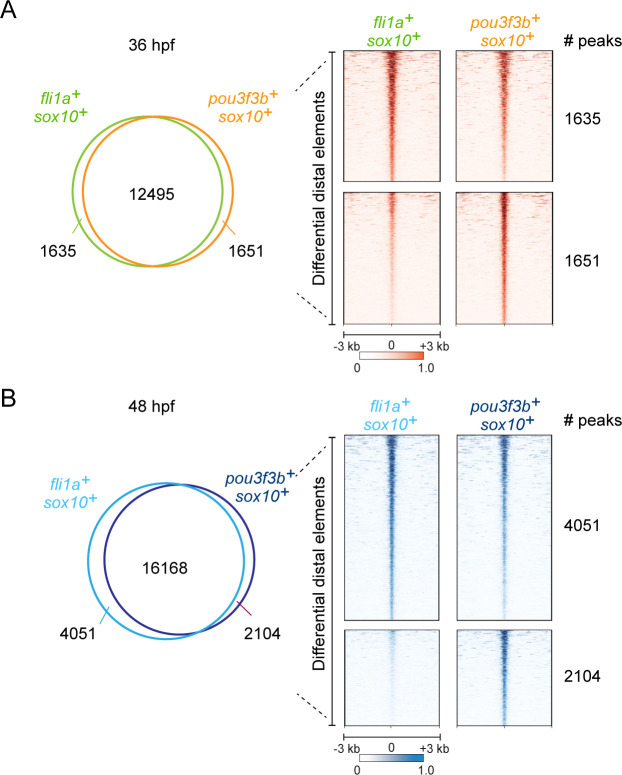
Comparison of accessible regions between pan- and dorsal CNCCs.Venn diagrams and heatmaps show distal accessible elements in μATACseq data from fli1a:GFP+; sox10:Dsred+ (pan-CNCCs) and pou3f3b>GFP+; sox10:DsRed+ (dorsal CNCCs) at 36 hpf (A) and 48 hpf (B). Numbers list elements unique for each population or shared (center of circles).